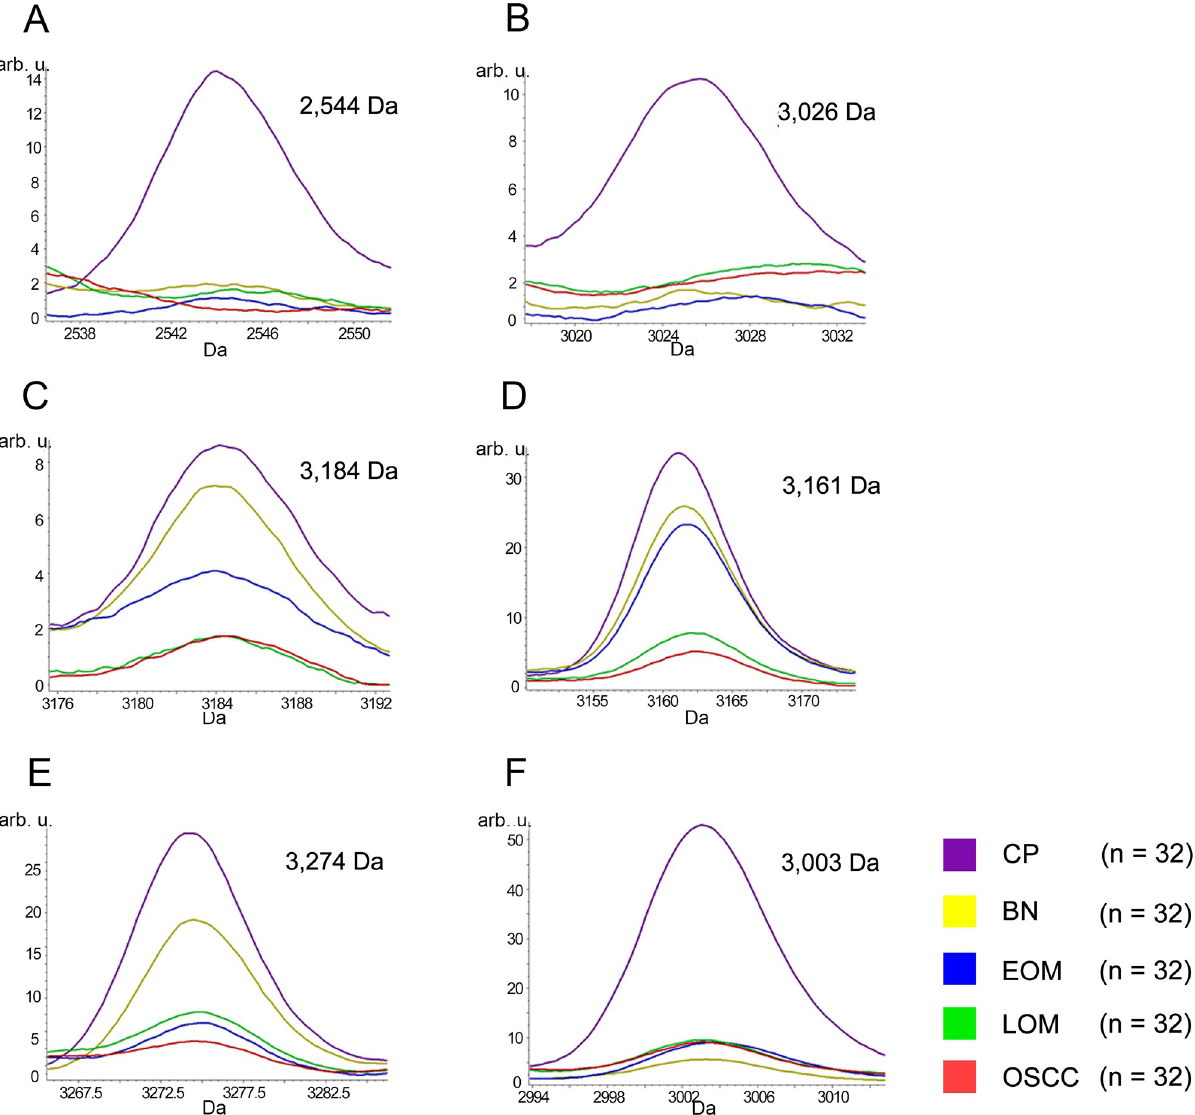
Fig 4. MALDI-TOF intensity profiles of salivary proteins from normal and periodontitis gingiva tissues (CP), benign tumors (BN), early-stage oral melanoma (EOM), late-stage OM (LOM) and oral squamous cell carcinoma (OSCC). Percentages of interpretable mass signals are shown: ZNF451 at 2544 Da (A); CASPL4A2 at 3026 Da (B); glypican 5 at 3184 Da (C); CEP192 at 3161 Da (D); cell-cycle checkpoint protein RAD17 at 3274 Da (E); protocadherin FAT1 at 3003 Da (F). arb. u., arbitrary unit.